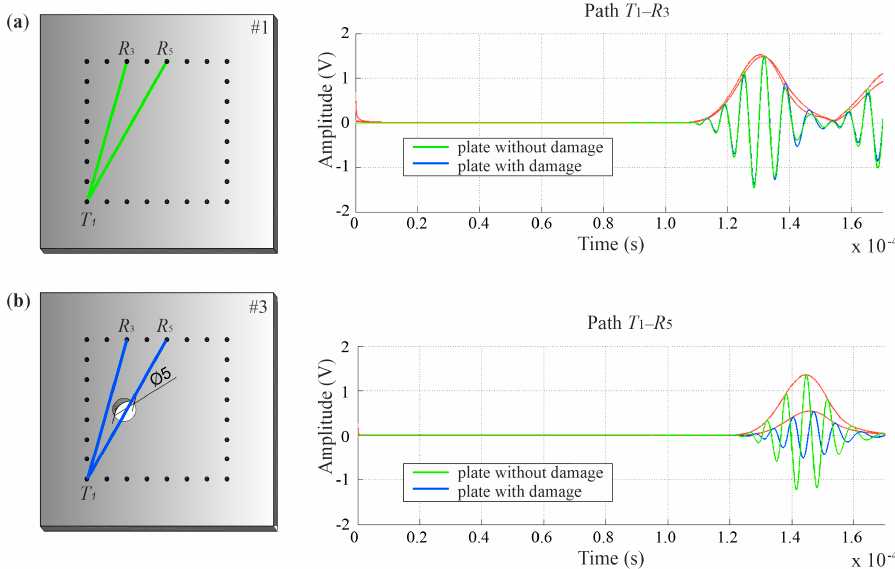
Figure 10. Comparison of wave signals propagated in intact plate ( a ) and plate with a 5 cm hole ( b ) along traces T 1 – R 3 and T 1 – R 5 .